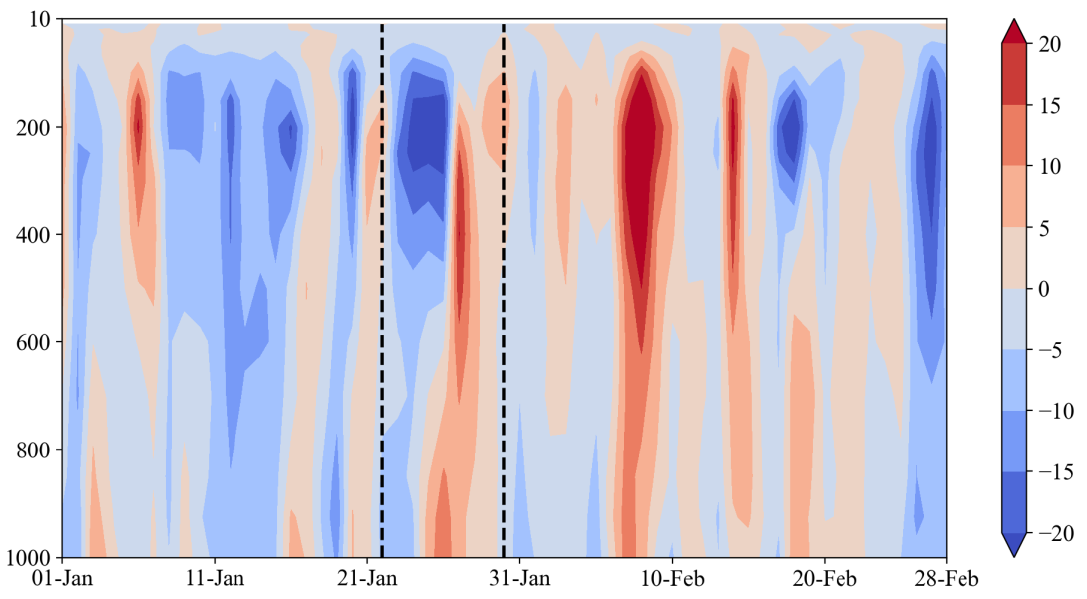
Figure 5. Vertical distribution of the meridional wind over Harbin (127.5°E, 45°N) during January – February 2019. The black dotted lines are the period of significant north – south wind shift.